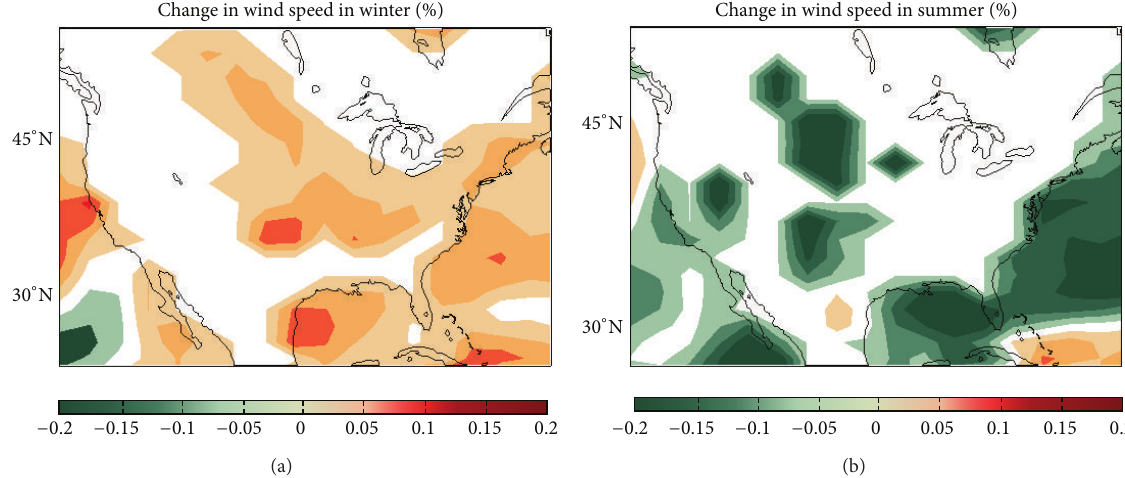
Figure 8: The multimodel mean of the percentage change in surface wind speed over North America for winter (a) and summer (b). See text for definition. Red indicates an increase and green indicates a decrease in wind speed. The values range from − 20% to 20%, as indicated by the color scale at the bottom.